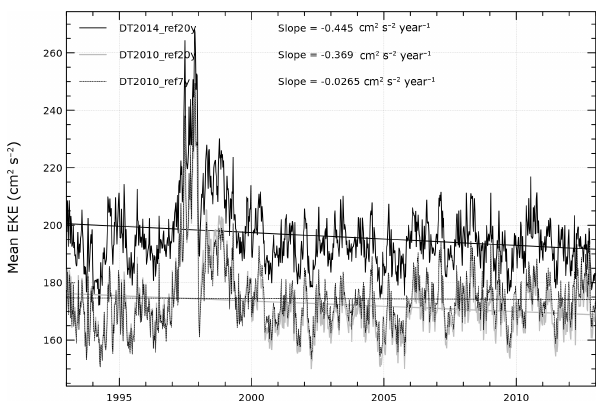
Figure 10. Evolution of the mean EKE over the global ocean (selec- tion of latitudes lower than 60 ◦ ), computed from the DT2014 (black line) and DT2010 SLA gridded products referenced to the 20-year period (black dotted lines) or to the 7-year period (grey lines). The same methodology (finite differences) was used for the geostrophic current computation for DT2010 and DT2014.